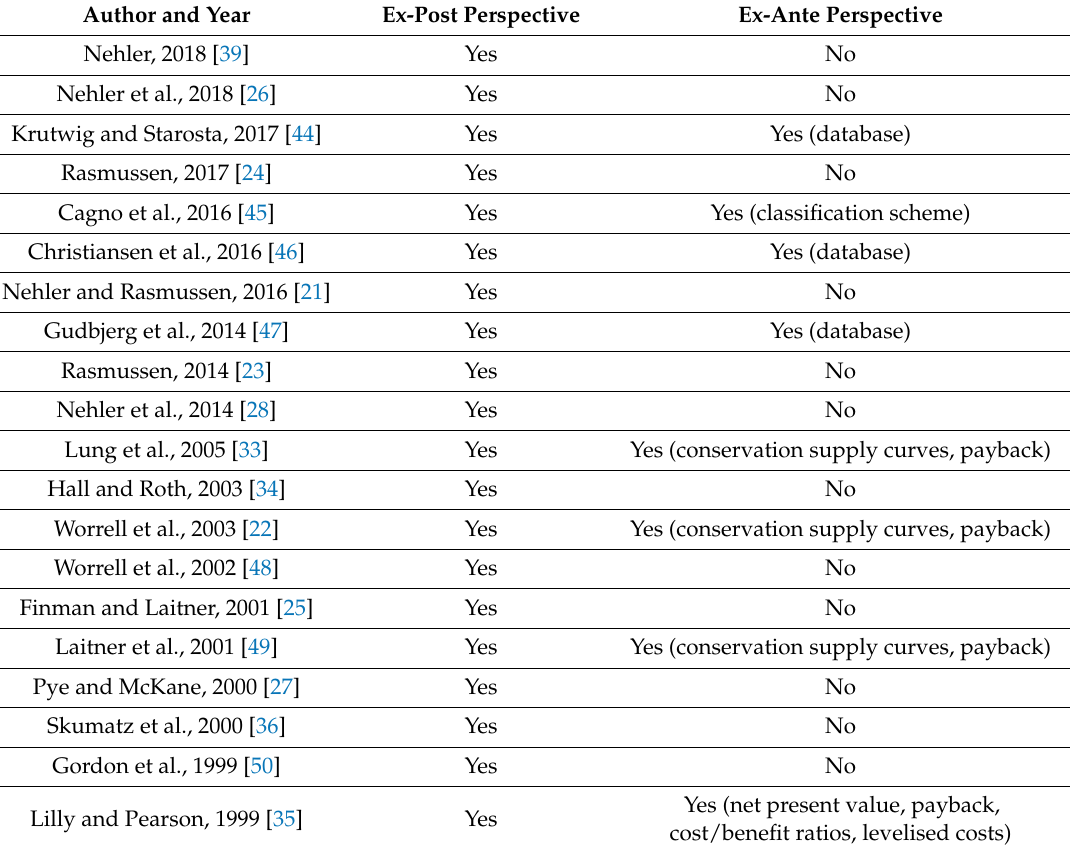
Table 2. The time perspective applied in studying non-energy benefits in the reviewed publications in the area of non-energy benefits in